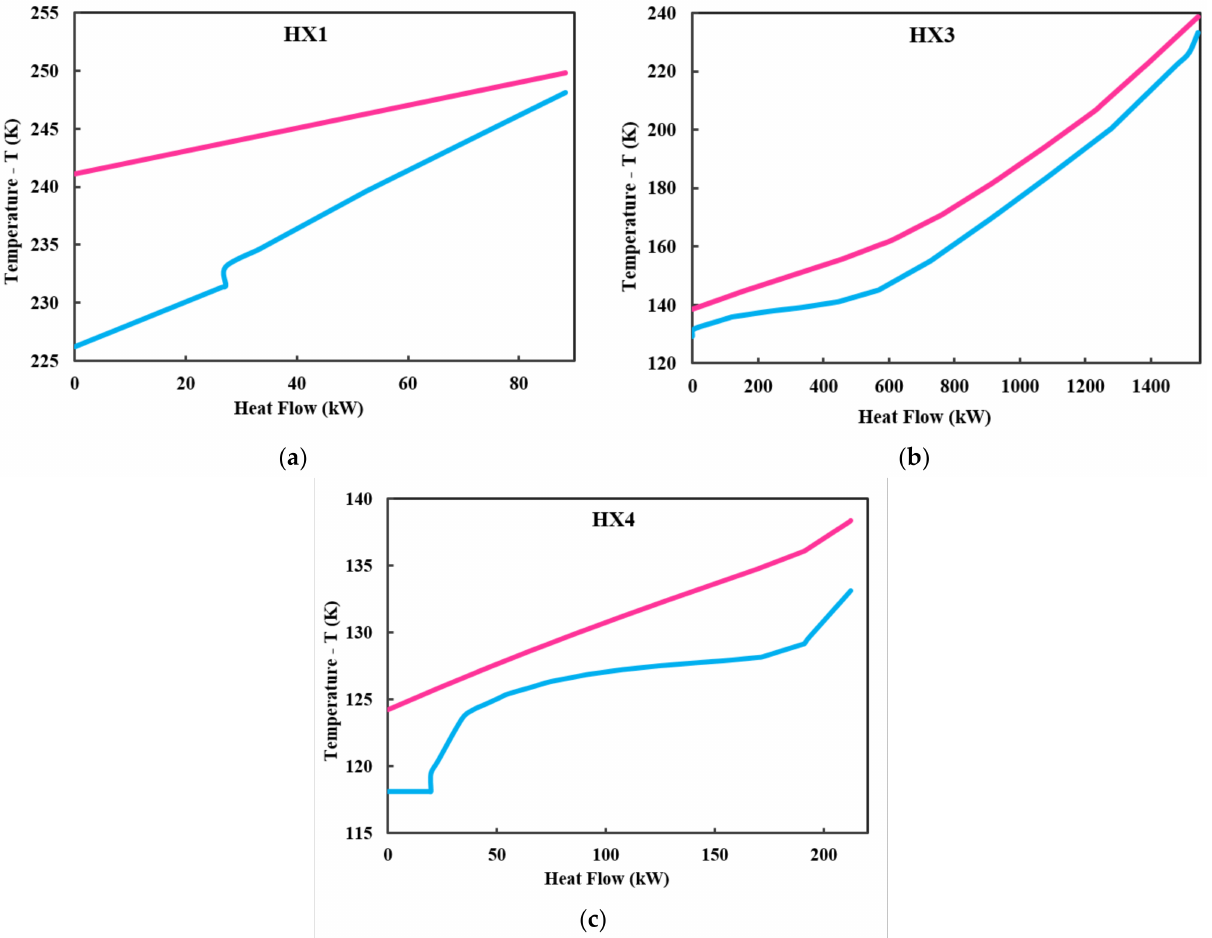
Figure 7. Hot (pink) and cold (blue) composite curves for ( a ) HX1, ( b ) HX3, and ( c )